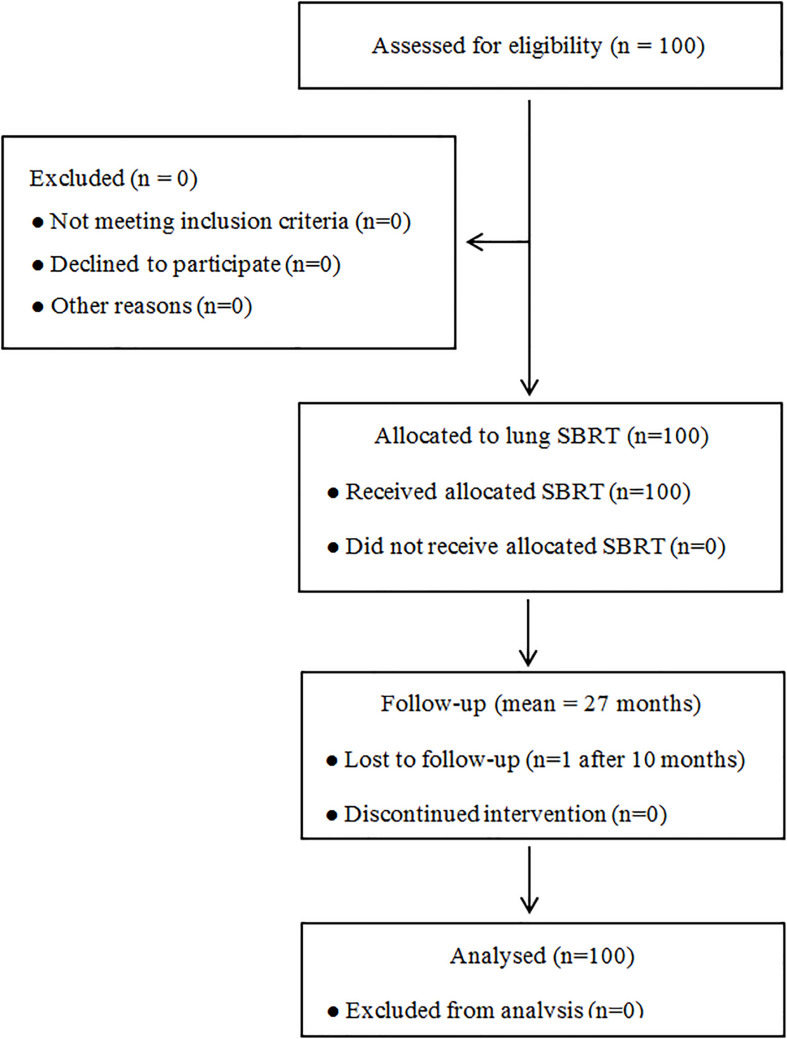
Flowchart of the patient enrollment process of study cohort.